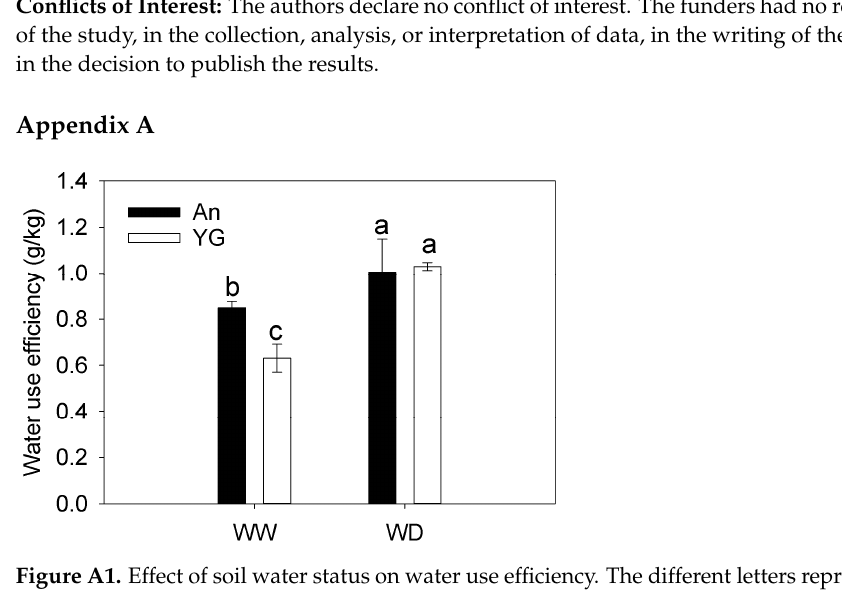
Figure A1. Effect of soil water status on water use efficiency. The different letters represent significant differences of WD, WW, An and YG ( p < 0.05).